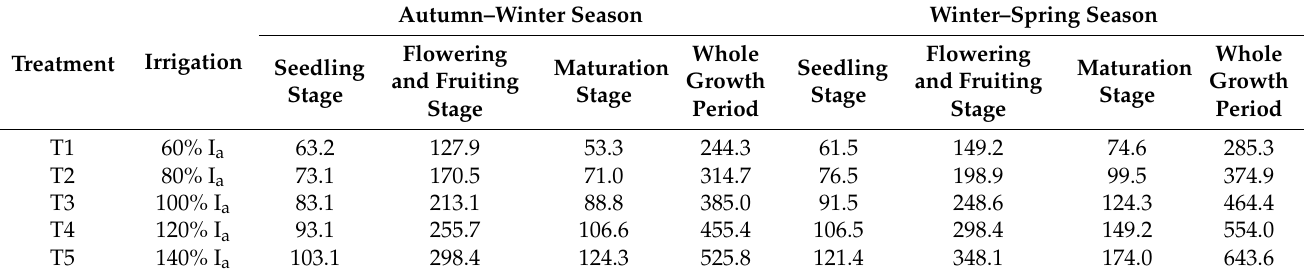
Table 3. Irrigation amounts (mm) applied to the experimental tomatoes during each growth stage and for the whole growth